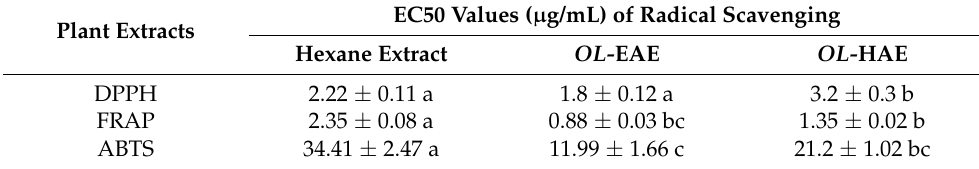
Table 2. Antioxidant activity of all Opuntia littoralis extracts. Plant